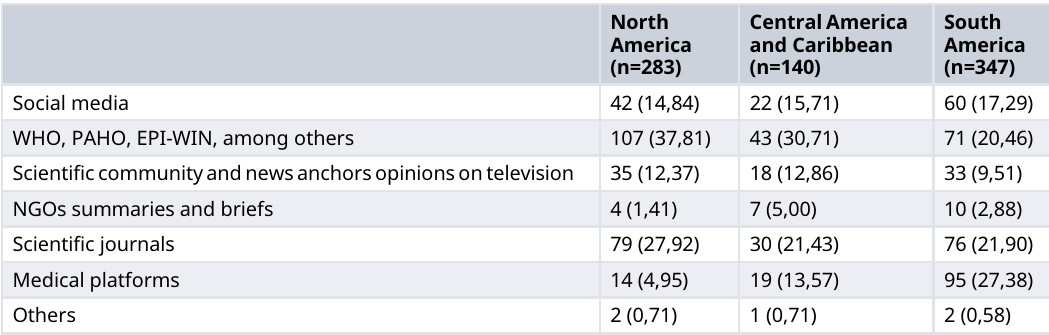
Figure 1. Preferences of type of article among medical students of Americas. Table 3. Comparison between medical students of different regions of America and main source of COVID-19